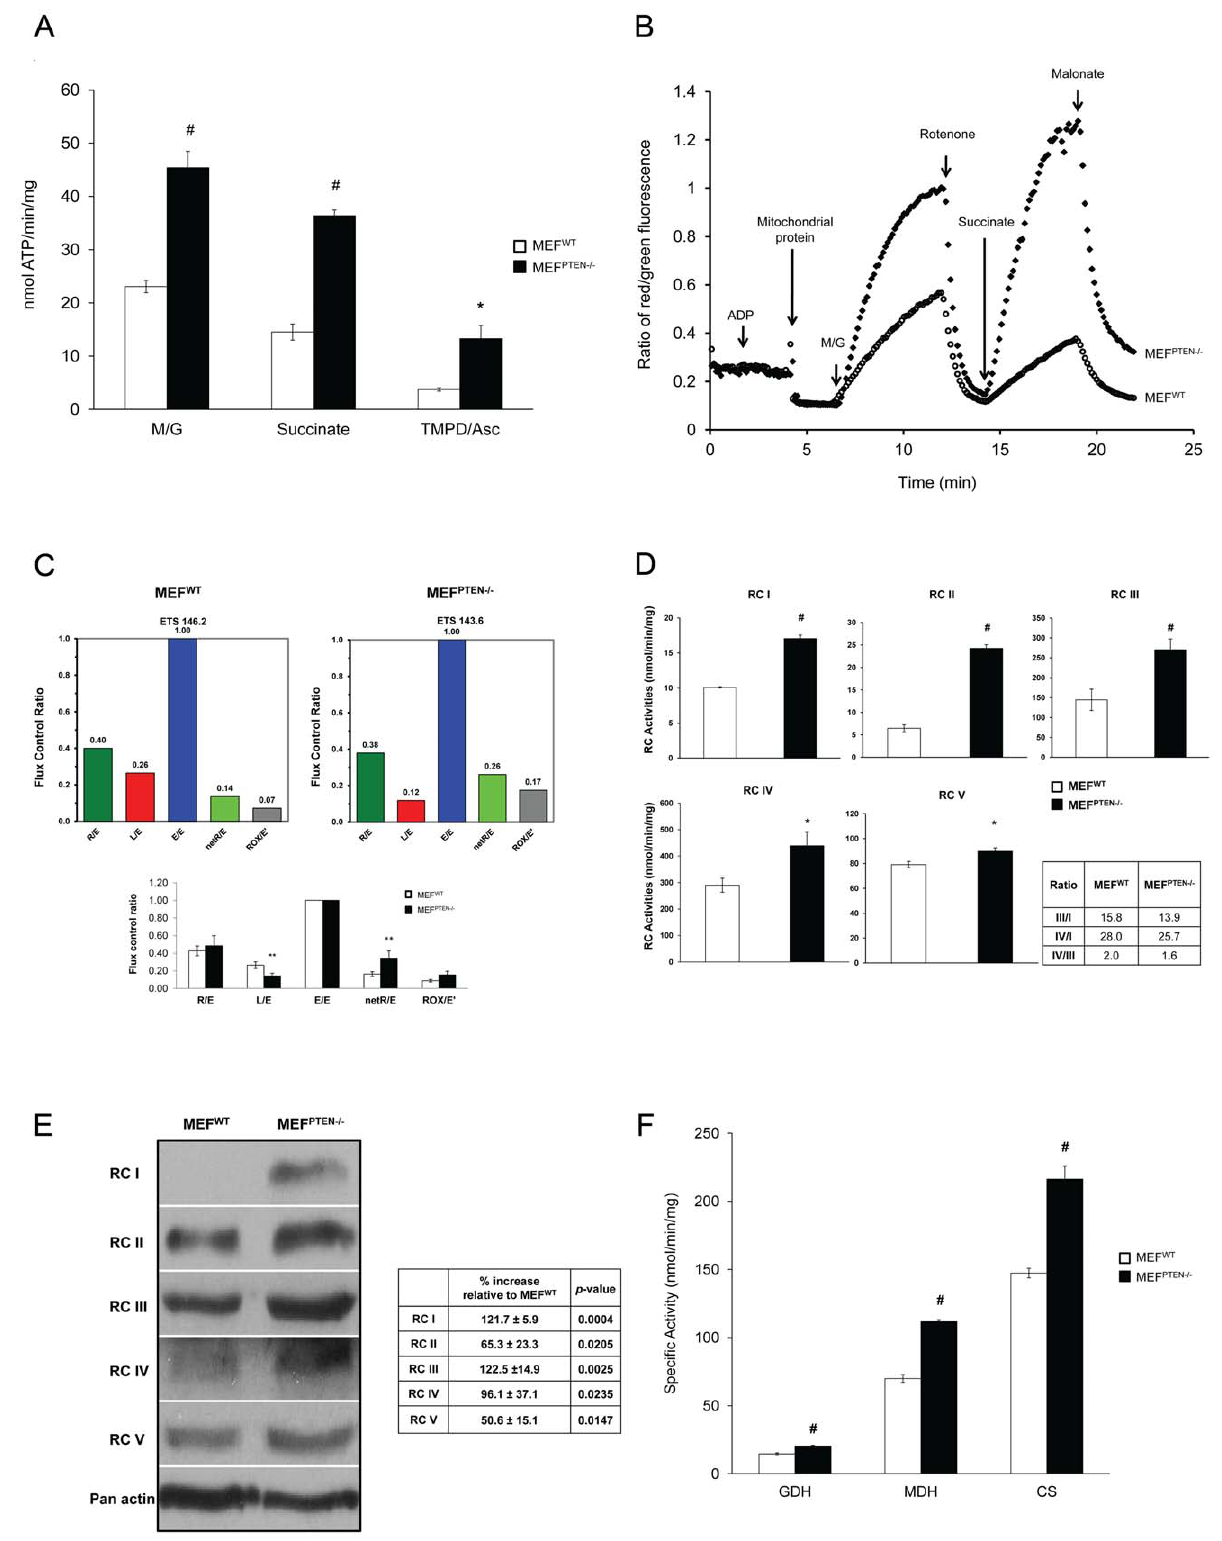
Figure 2. Mitochondrial parameters in MEF WT and MEF PTEN 2 / 2 . ( A ) Biosynthesis of ATP This was carried out in isolated mitochondria which showed a higher rate of ATP generation in MEF PTEN 2 / 2 compared to MEF WT . The respiratory substrates ( 6 inhibitor) were 5 mM each of malate/ glutamate (M/G), 10 mM succinate + 5 m M rotenone, and 1 mM TMPD and 5 mM ascorbate in the presence of 2 m g/ml antimycin A. * p , 0.05, # p , 0.005 for n=3. ( B ) Mitochondrial membrane potential The cationic dye, JC-1was used to monitor the mitochondrial membrane potential (MMP). JC- 1 monomers (green fluorescence) form J-aggregates (red fluorescence) in the matrix upon energization by added respiratory substrates namely